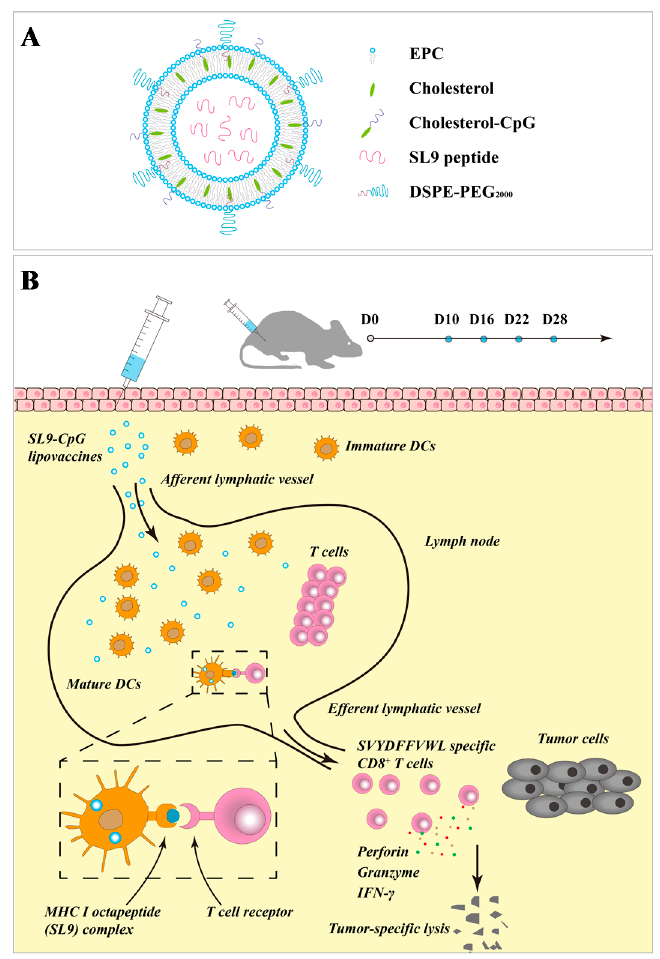
Figure 1. Illustrations of structure and action mechanism of SL9-CpG lipovaccines. Schematic presentation for the structure of SL9-CpG lipovaccines ( A ). Illustration for action mechanism of SL9-CpG lipovaccines ( B ). EPC, egg phosphatidylcholine; CpG, cytosine triphosphate deoxynucleotide-phosphodiester-guanine triphosphate deoxynucleotide; DCs, dendritic cells; MHC I, major histocompatibility complex I.